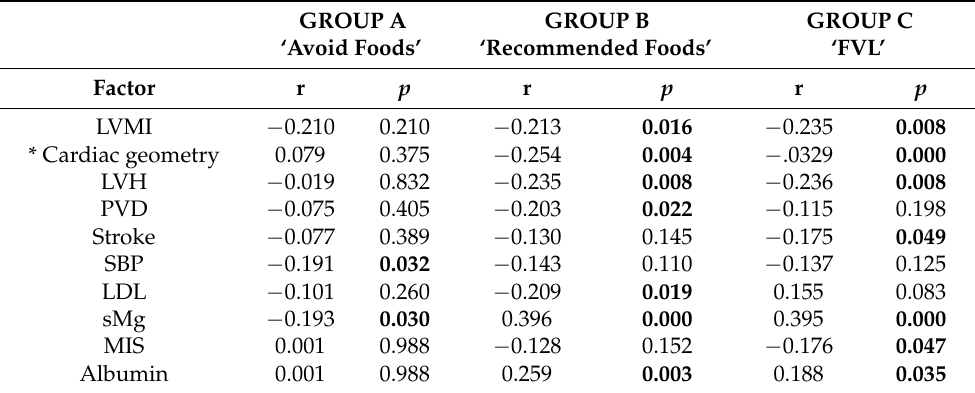
Table 7. Associations of CVD risk factors with Mediterranean Diet food categories. GROUP A GROUP B ‘Avoid Foods’ ‘Recommended Foods’